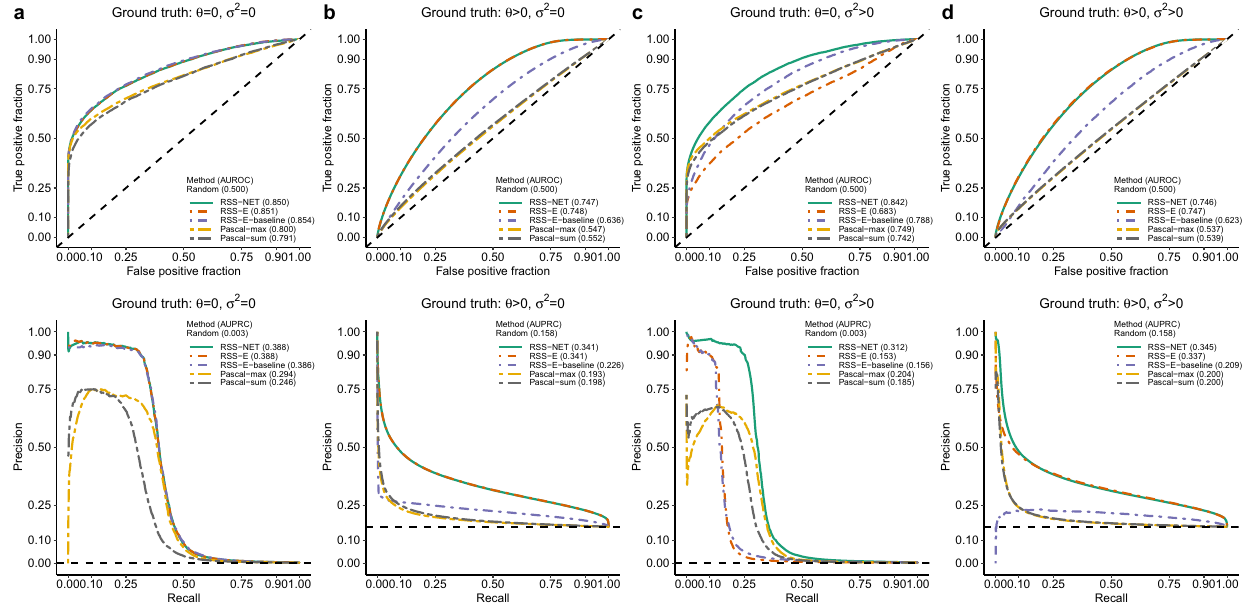
Fig. 4 Power of RSS-NET to identify gene-level associations from GWAS summary statistics. We used a B cell-speci fi c regulatory network and real genotypes of 348,965 genome-wide SNPs to simulate individual-level GWAS data under four scenarios: a θ = 0, σ 2 = 0; b θ > 0, σ 2 = 0; c θ = 0, σ 2 > 0; d θ > 0, σ 2 > 0. Using the simulated individual-level data we computed single-SNP association statistics, on which we compared RSS-NET with gene- level association components of RSS-E 16 and Pascal 26 . RSS-E is a special case of RSS-NET assuming σ 2 = 0, and RSS-E-baseline is a special case of RSS- E assuming θ = 0. Pascal includes two gene scoring options: maximum-of- χ 2 ( “ max ” ) and sum-of- χ 2 ( “ sum ” ). Given a network, Pascal and RSS-E- baseline do not leverage any network information, RSS-E ignores the edge information, and RSS-NET exploits the full topology. Each scenario contains 200 datasets and each dataset contains 16,954 autosomal protein-coding genes for testing. We de fi ned a gene as "trait-associated'' if at least one SNP j within 100 kb of the transcribed region of this gene had non-zero effect ( β j ≠ 0). For each gene in each dataset, RSS methods produced posterior probabilities that the gene was trait-associated ( P 1 ), whereas Pascal methods produced association P -values; these statistics were used to rank the signi fi cance of gene-level associations. The fi rst row of each panel displays ROC curves and AUROCs for all methods, with dashed diagonal lines indicating random performance (AUROC = 0.5). The second row of each panel displays precision-recall (PRC) curves and areas under PRC curves (AUPRCs) for all methods, with dashed horizontal lines indicating random performance. For both AUROC and AUPRC, higher value indicates better performance. Simulation details and additional results are provided in Supplementary Figs. 7,